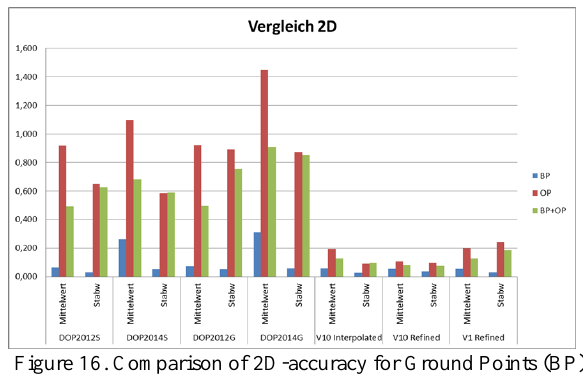
Figure 16. Comparison of 2D-accuracy for Ground Points (BP)